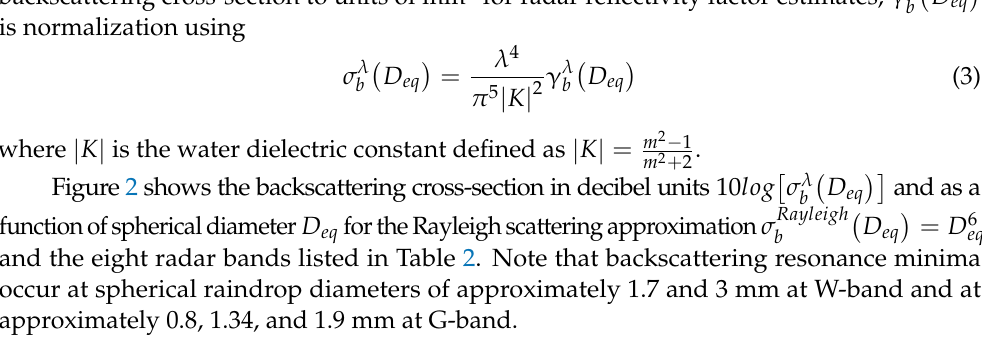
Figure 2. Normalized backscattering cross-section at vertical incidence expressed in decibel units 10𝑙𝑜𝑔[𝜎 𝑏𝜆 (𝐷 𝑒𝑞 )] verses equivolumetric spherical raindrop diameter 𝐷 𝑒𝑞 . ( a ) Rayleigh scattering re- gime and radar S-, C-, and X-bands. ( b ) Radar Ku-, K-, Ka-, W-, and G-bands.